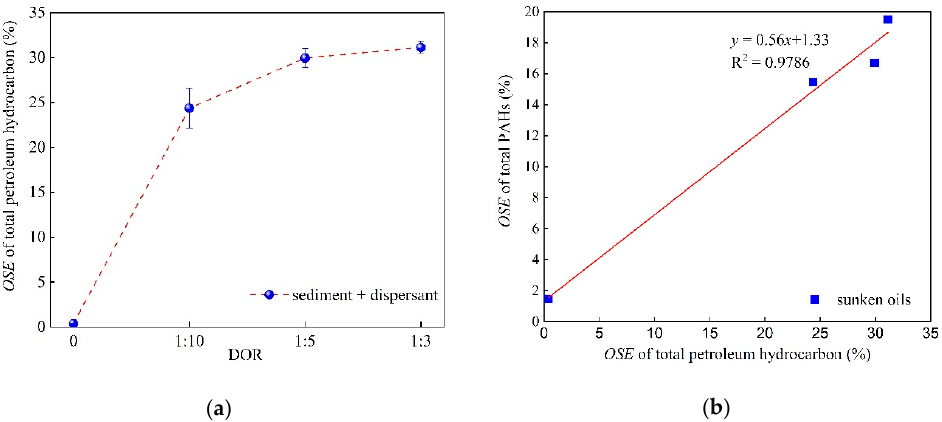
Figure 6. ( a ) The OSE of total petroleum hydrocarbons (TPH) in the sunken oils in the presence of GM-2 and quartz sand; ( b ) The Pearson’s correlation of OSE between total PAHs and